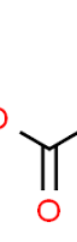
Figure 13. Niacin structure.